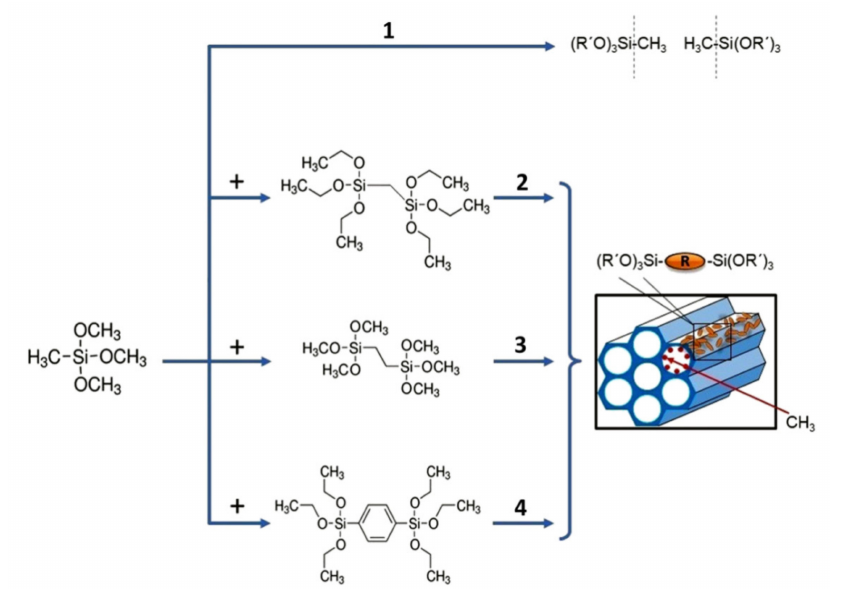
Figure 1. Porous organosilicate glass films prepared by using only methyltrimethoxysilane ( 1 ) or its mixture with one of the following alkylenesiloxane: 1,2-bis(triethoxysilyl)methane ( 2 ), 1,2-bis(trimethoxysilyl)ethane ( 3 ) or 1,4-bis(triethoxysilyl)benzene ( 4 ). After evaporation-induced self-assembly (EISA) deposition, the bridging carbon groups are located on the pore wall